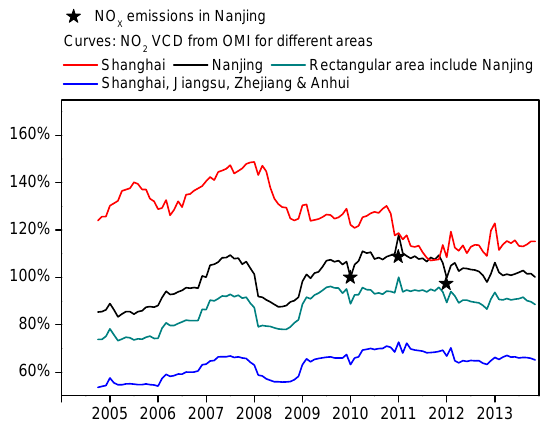
Figure 4. The interannual trends in NO 2 vertical column density (VCD) from OMI for selected regions (see Fig. S1a for reference) and the bottom-up NO x emissions for 2010–2012. All the data are normalized to 2010 level in